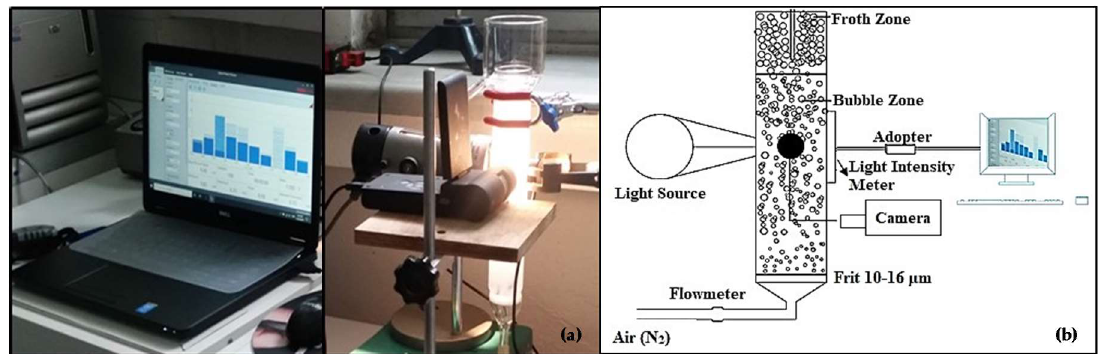
Figure 1. ( a ) Experimental set-up of bubble coalescence measurement; ( b ) Schematic representation of bubble coalescence measurements [56].